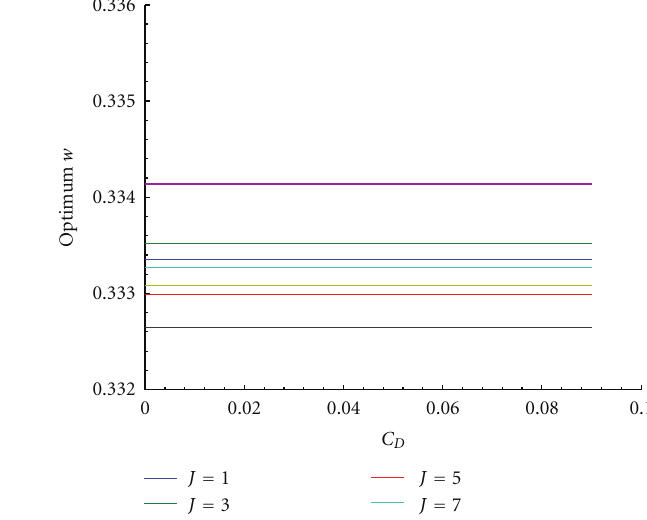
Figure 13: Optimum w versus C D